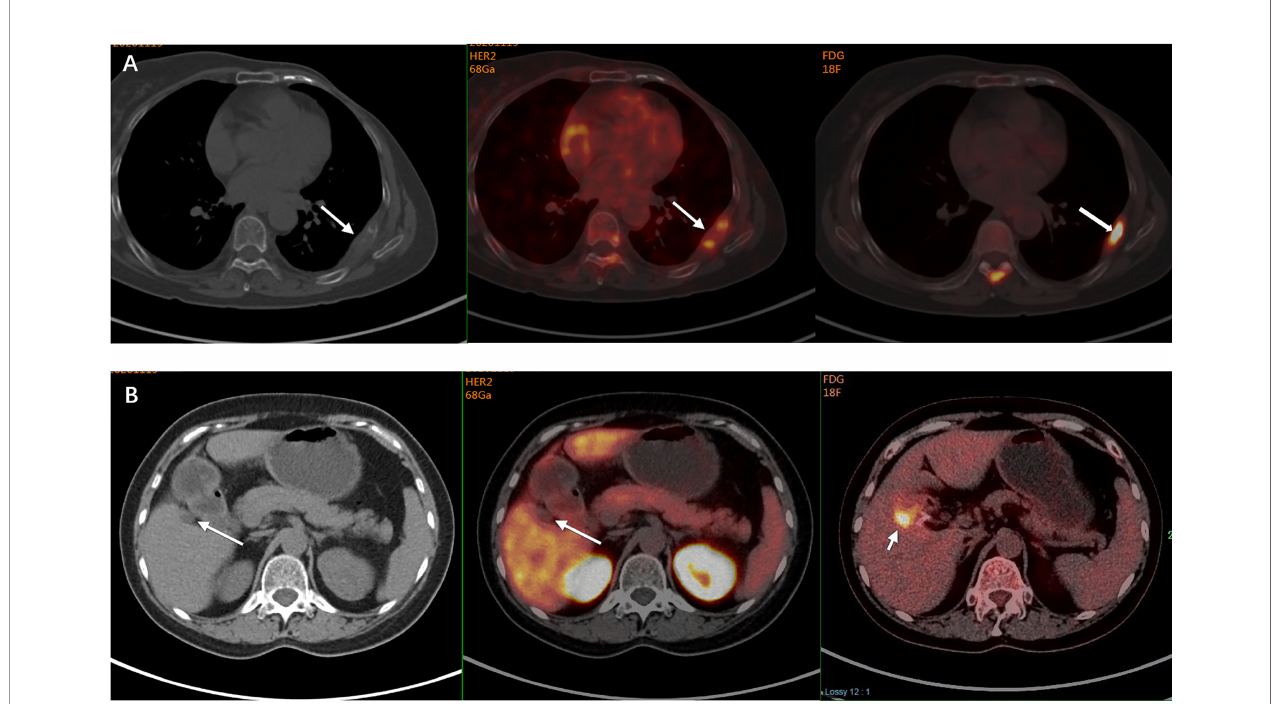
FIGURE 2 | A 60-year-old woman was diagnosed with primary ER-negative/HER2-positive invasive ductal breast carcinoma. Two years later, she developed bone metastases in her left posterior ribs. PET/CT also demonstrated a hypodense shadow in the right anterior lobe of the liver with increased FDG uptake on the FDG PET, and a liver metastasis was suspected. Subsequent 68 Ga-HER2 af fi body PET/CT showed that the HER2 uptake in the left posterior rib was increased (arrow, SUV max of 4.4) (A) , while no 68 Ga-HER2 af fi body avidity was found in the right anterior lobe of her liver close to the gallbladder fossa though increased FDG uptake was shown in the same site (arrow) (B) . The pathology of liver biopsy revealed that the suspicious lesion in her liver was actually the in fi ltration of in fl ammatory cells in the liver portal area. The manifestation on 68 Ga-HER2 af fi body PET/CT scan was consistent with the pathology, which suggested the extended use of HER2 PET in the discrimination of